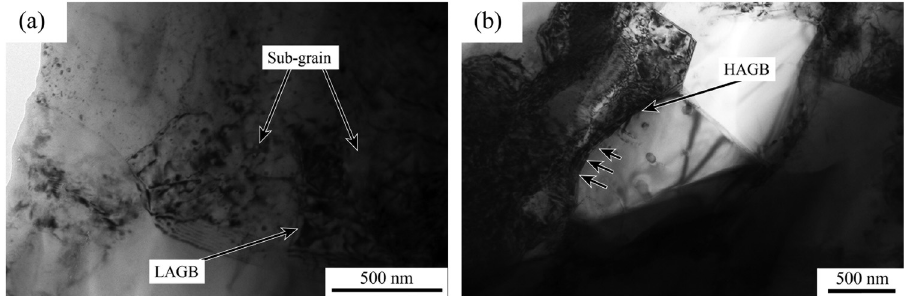
Figure 11: TEM images of nano - SiCp/Al – 7Si matrix composites at deformation temperature of 530°C and strain rate of 1 s − 1